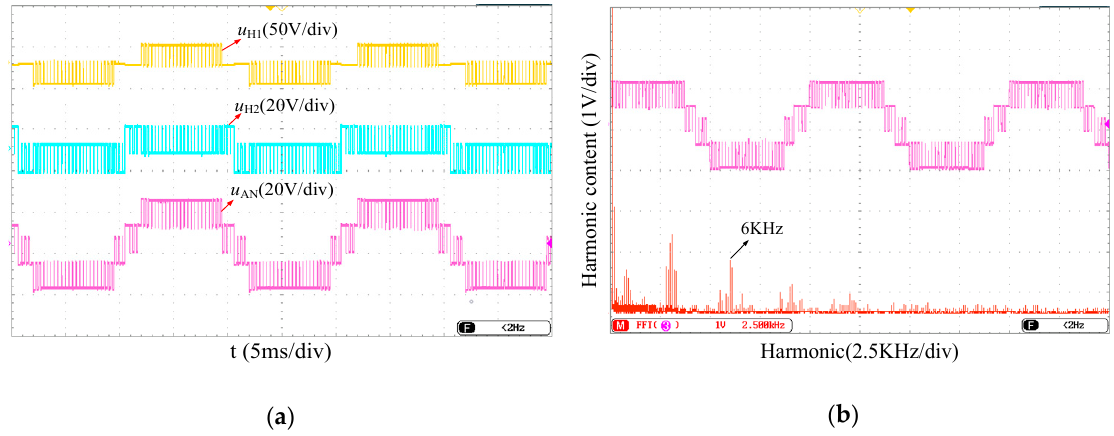
Figure 15. Experiment result (m = 0.6, frl = 3 KHz). ( a ) Output voltage of each unit in two cycles. ( b ) Phase voltage spectrum.